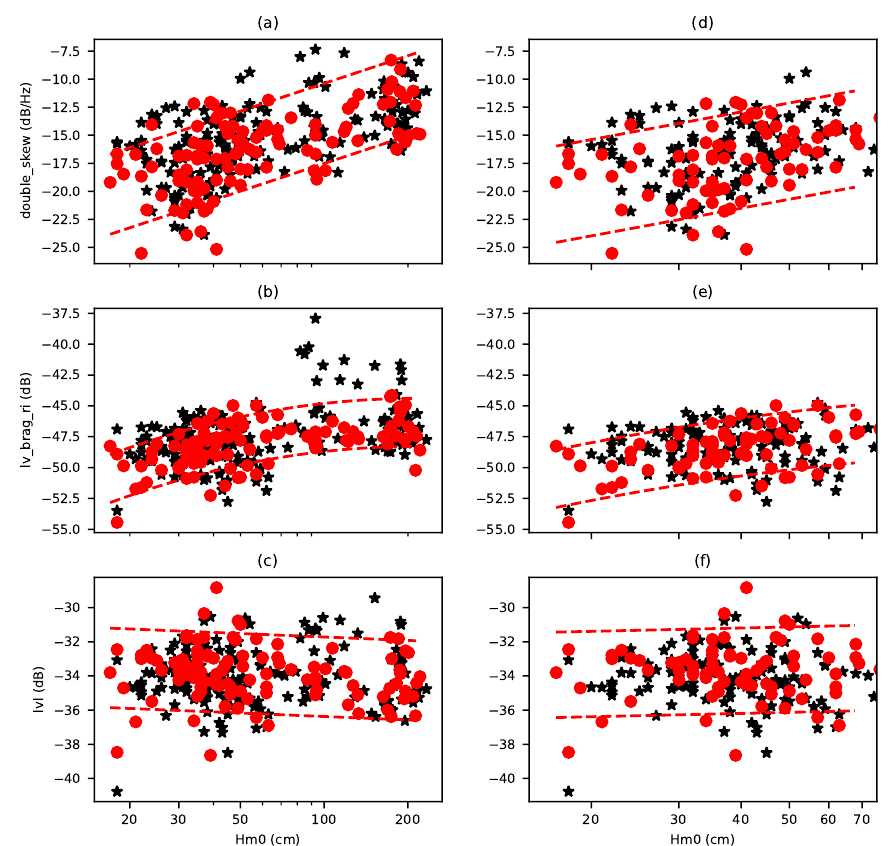
Figure 7. Dependence between features and a significant wave height. A set of features is studied: ( a ) double _ skew = sk _ ri − sk _ le , ( b ) lvl _ brag _ ri and ( c ) lvl that stands for a total level; ( d – f ) are scaled versions of ( a – c ). Red filled dots are the data without a significant shift of Doppler centroid ( | centr 1 | < 0.075 Hz) and stars represent the rest of the dataset. Dashed lines represent confidence intervals around a fitting line or curve. Right panels are scaled versions of left panels.